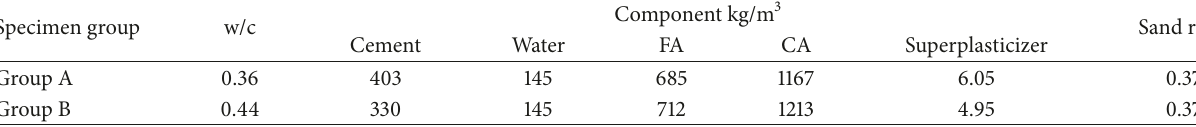
Table 1: Concrete mixture proportions.